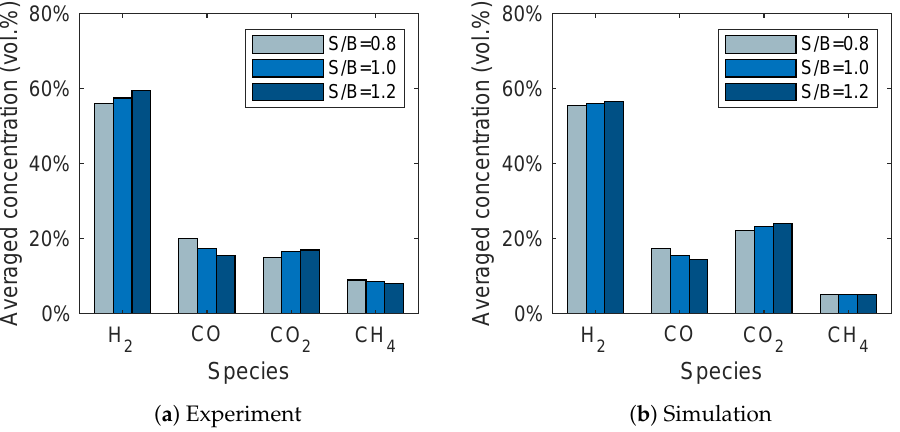
Figure 10. Influence of the steam-to-biomass ratio on the syngas composition for ( a ) the experimental data given by Song et al. [6] and ( b ) the simulation